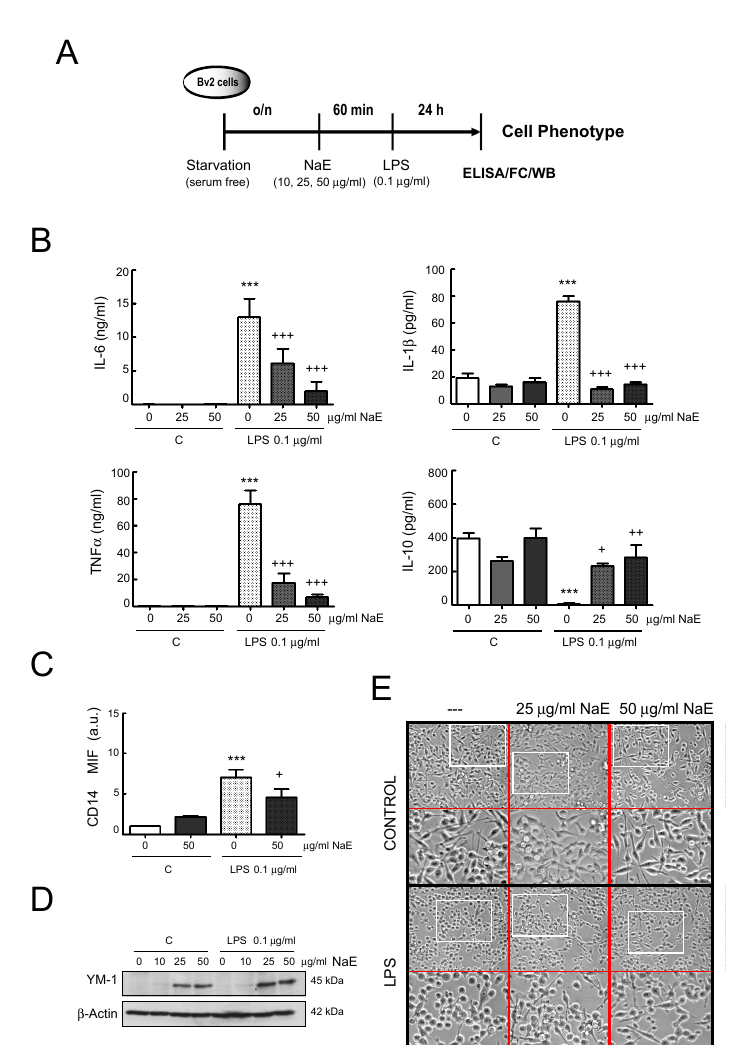
Figure 4. NaE extract modulates the M1 phenotype induced by LPS in BV2 cells. ( A ) Experimental steps. BV2 cells were incubated for 1 h at 37 °C with the indicated doses of the NaE extract, and then stimulated with or without 0.1 µg/mL of LPS for 24 h. ( B ) Levels of IL-6, TNF- α , IL-1 β and IL-10 were determined in the culture supernatants using commercial ELISA kits. Values are means ± SD (n = 3–5). *** p < 0.001 vs. controls; and +++ p < 0.001, ++ p < 0.01 and + p < 0.05 vs. LPS-treated cells. ( C ) Expression of CD14 on cell surface was evaluated by flow cytometry analysis. The graph represents MFI fold change values of CD14 normalized to untreated control cells. *** p < 0.001 vs. controls; and + p < 0.05 vs. LPS-treated cells. ( D ) Expression of YM-1 was evaluated by Western blot. ( E ) Representative photomicrographs showing changes in cell morphology after LPS stimulation in the presence or absence of NaE. Cells were photographed using a Nikon Eclipse TS100 microscope (200× and 400× magnification). N = 3. Western blot bar graphs are in supplementary material Figure S4.